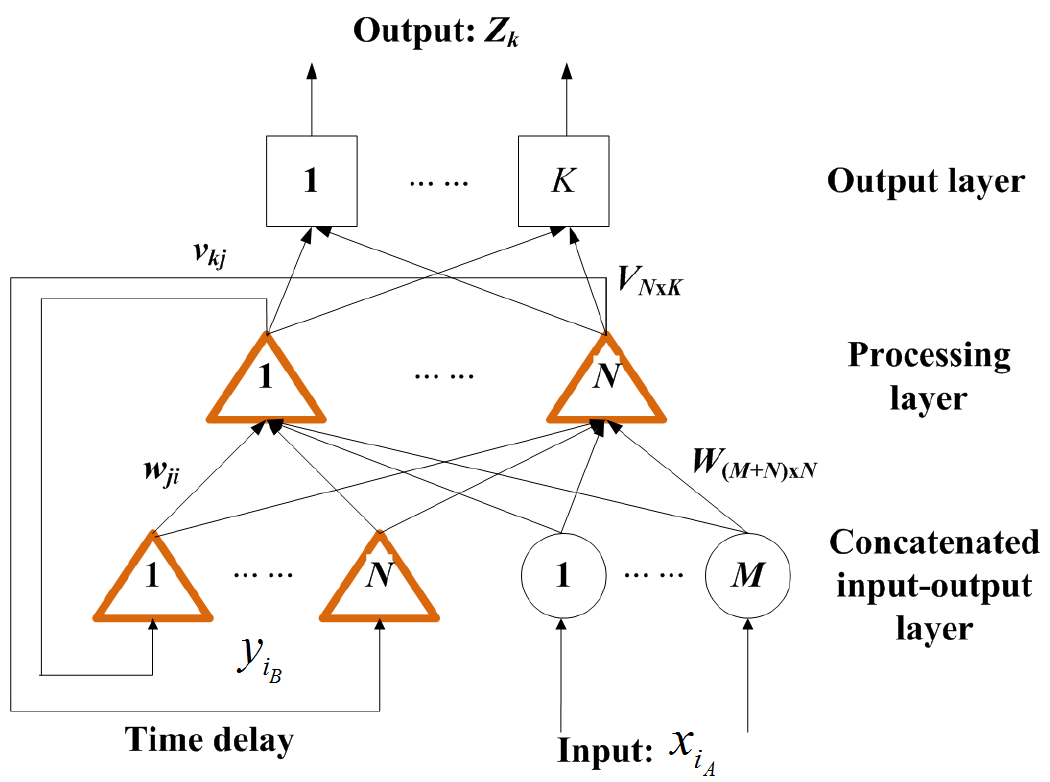
Figure 5. Structure of a